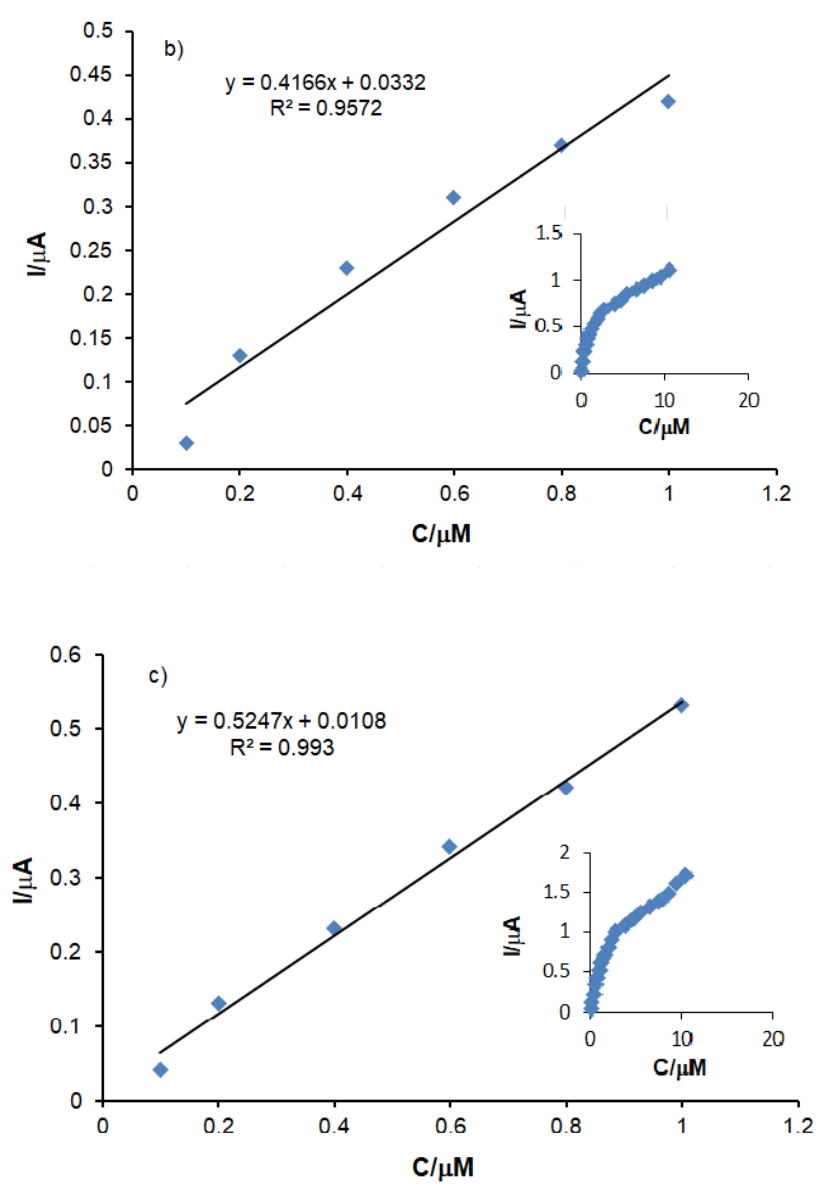
Figure 10. Dependence of the anodic peak as a function of L-DOPA concentration (0.1–1 µ M) for ( a ) C-SPCE, ( b ) MC-SPCE, ( c ) OMC-SPCE. The inserted figures show the dependence of the anodic peak depending on the concentration studied throughout the entire concentration range (0.1–10.48 µ M). Table 4. Calibration linear equations, detection and quantification limits of the three carbon-based sensors.